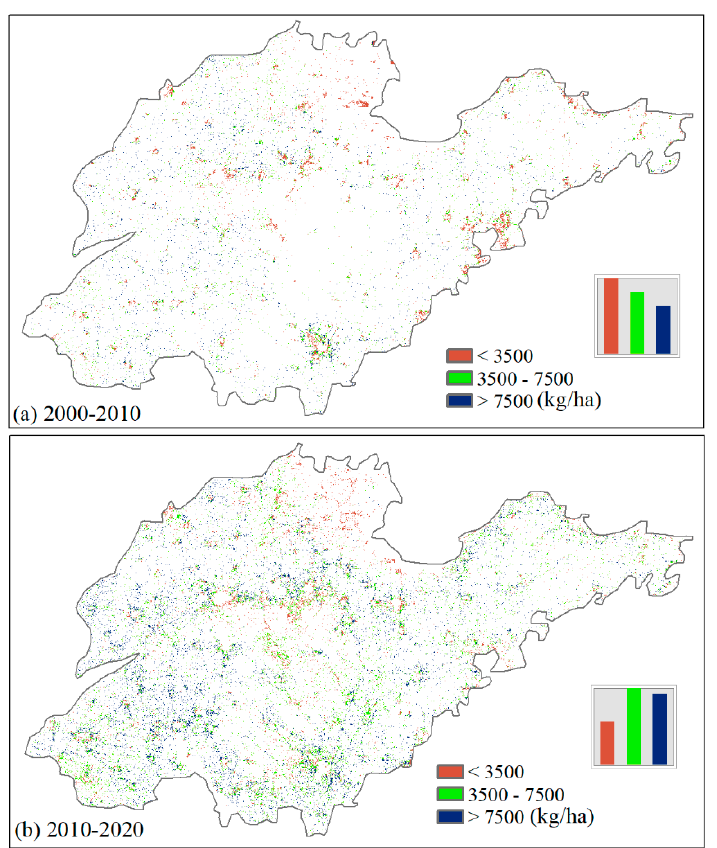
Figure 6. Potential yield of Shandong Province simulated by the GAEZ model.